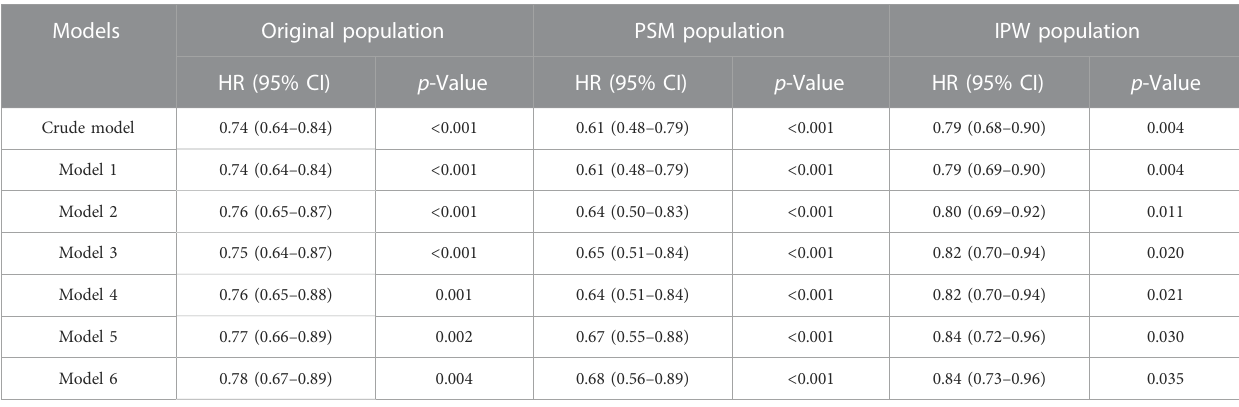
TABLE 2 Results of Cox proportional hazard